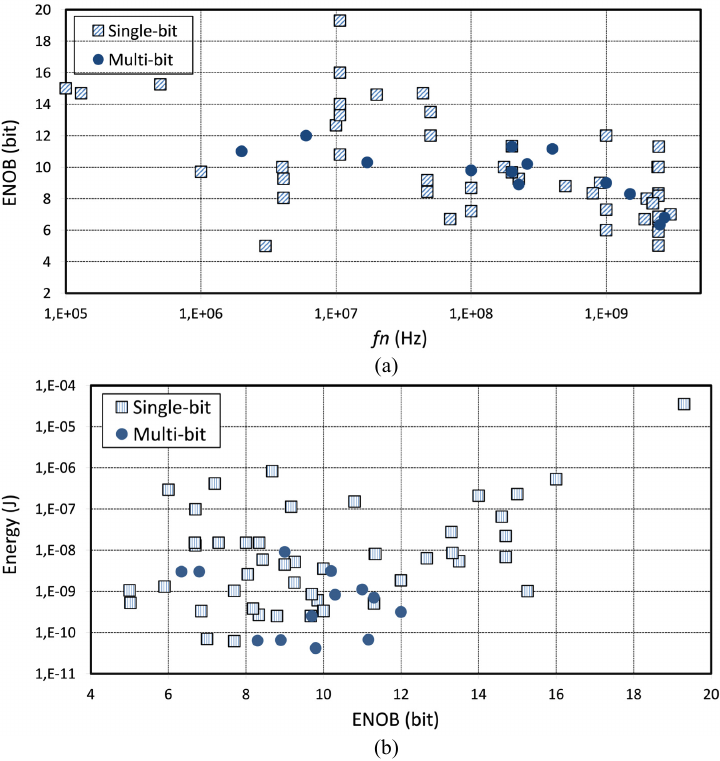
Figure 18. Single-bit vs. multi-bit BP- Σ∆ Ms: ( a ) ENOB vs. f n , ( b ) energy